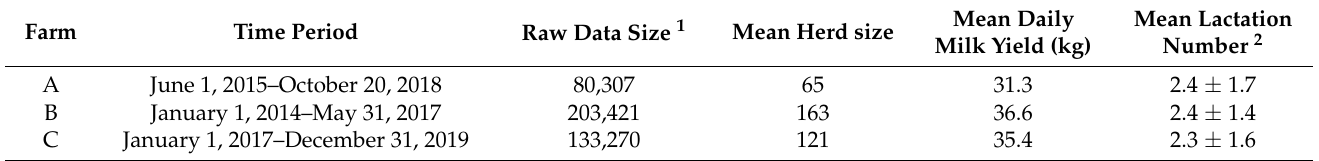
Table 1. Overview of the three farms and the amount of data